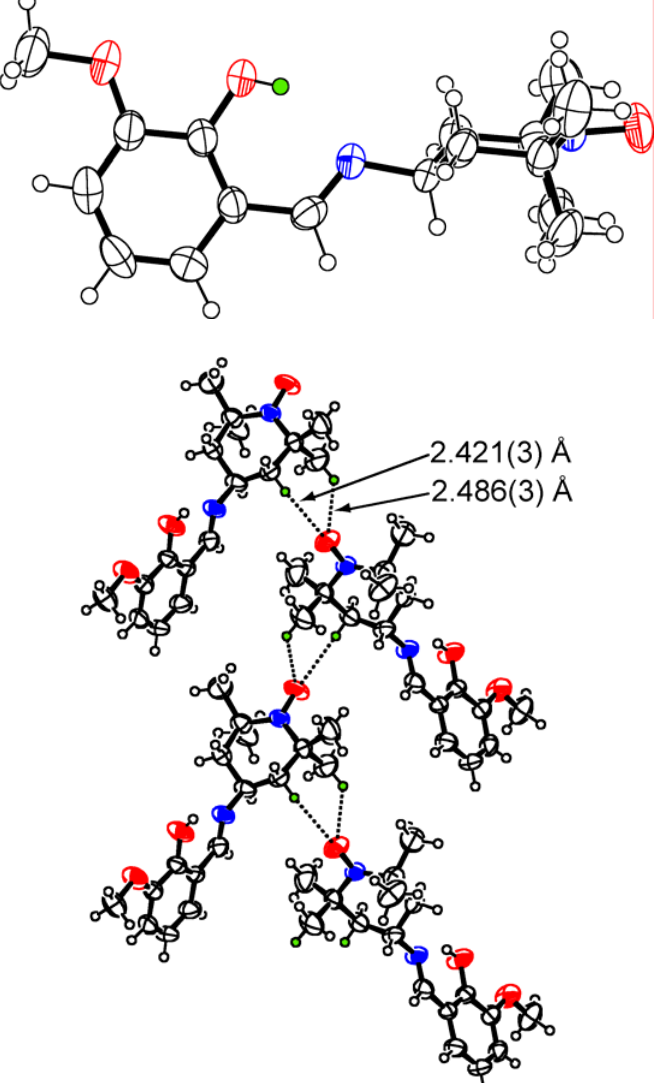
Figure 3. Molecular (upper) and crystal structure (lower) of 2b